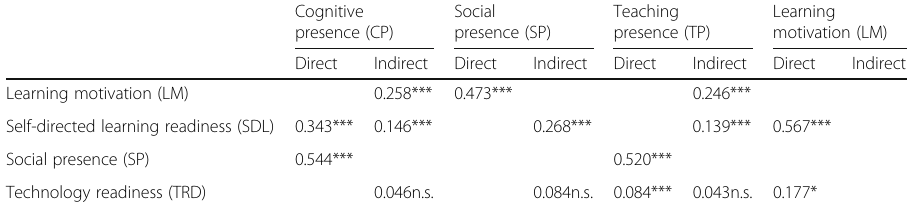
Table 7 Structural path coefficients for the BL group